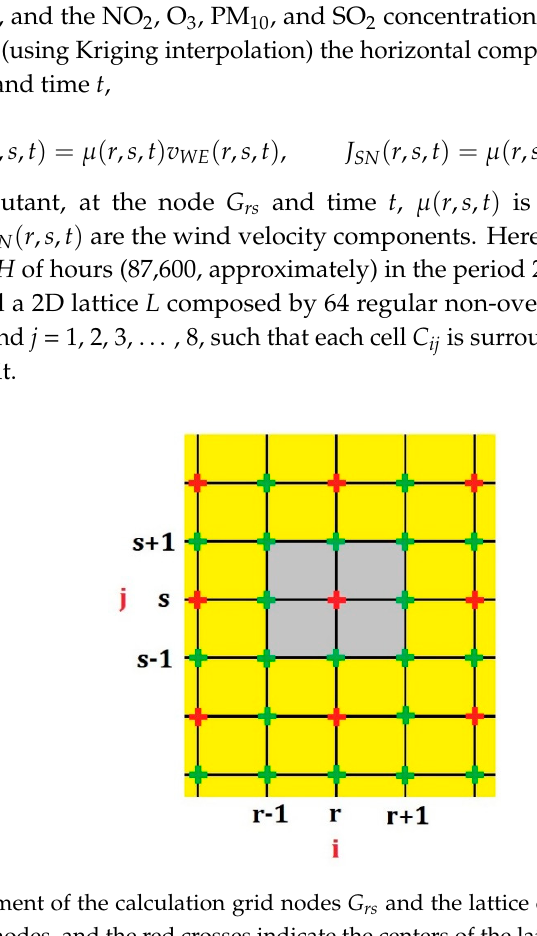
Figure 3. Spatial distribution of the stations (white dots) of the NO 2 , O 3 , PM 10 , and SO 2 monitoring networks (RAMA) of SIMAT. The RAMA provides 1-hour average values of the surface concentrations of NO 2 , O 3 , PM 10 , and SO 2 , among other chemical compounds.